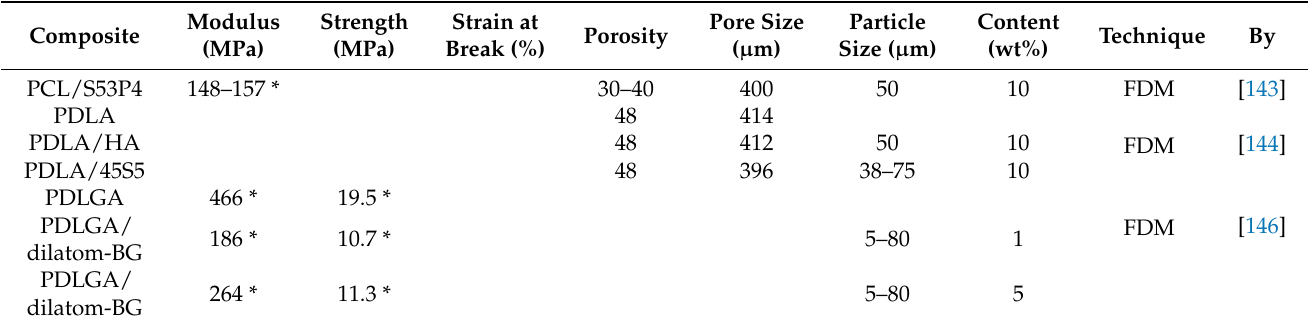
Table 4. Principal properties of FDM investigations. With * the compression (not filled cells mean no data).